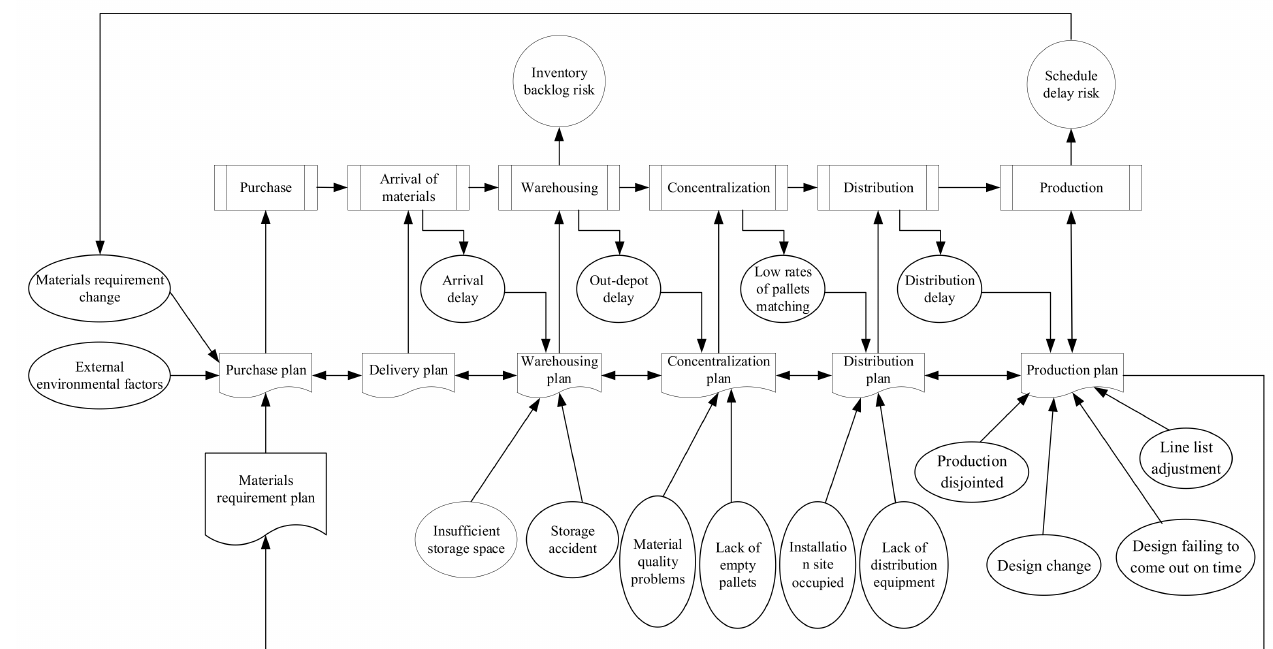
Figure 2. Risk propagation path of concentralized distribution logistics plan change.